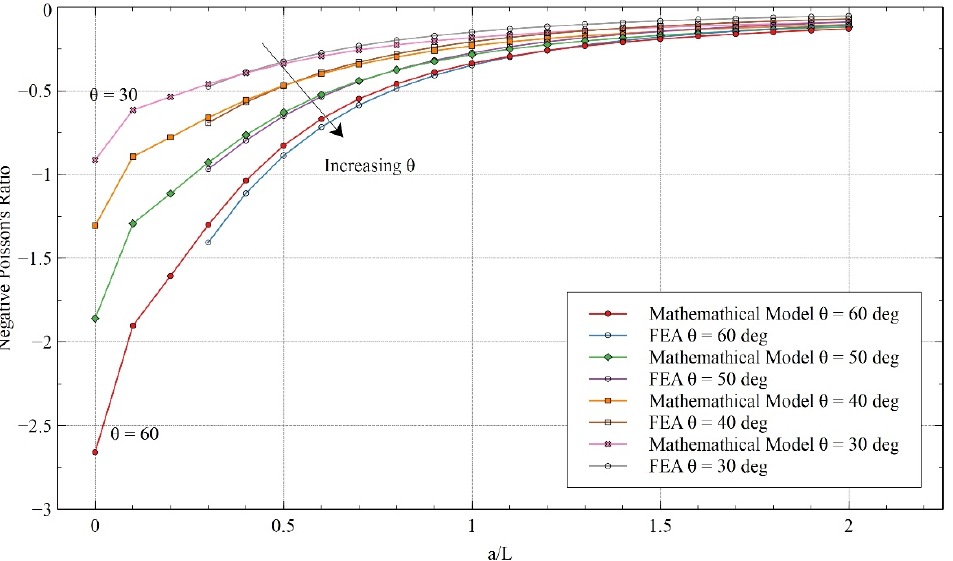
Figure 16. Comparison of Poisson’s ratio obtained from the FEA and mathematical model for varying angle θ for y-direction loading.